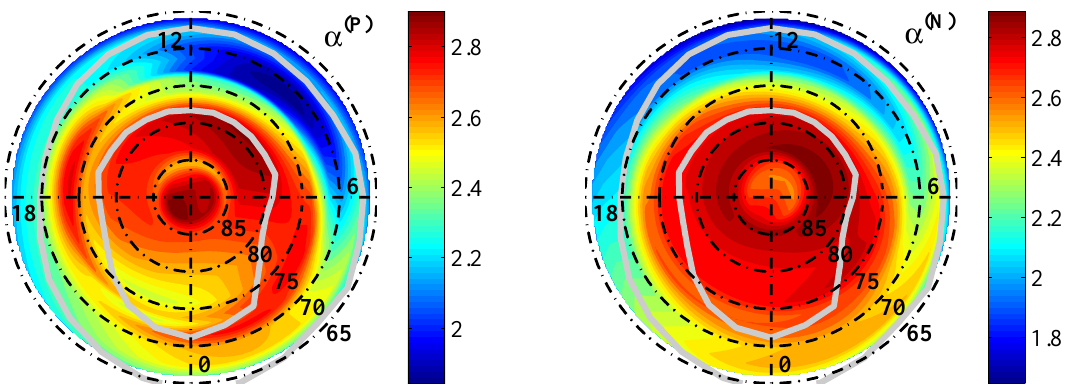
Fig. 7. 2-D distribution of the spectral slope α in 8 -MLT coordinates in the same format as in Fig. 5. The warm colors (large spectral slopes) correspond to spectra dominated by low frequencies and cool colors (low spectral slope) indicate that the spectra are enriched with high